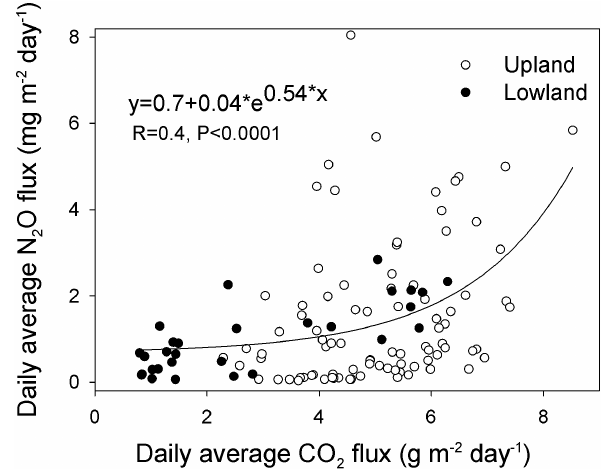
Fig. 2. N 2 O daily average fluxes plotted versus daily average CO 2 fluxes measured in the uphill and downhill sites. Plain line is a linear fit of data ( R 2 = 0 . 57, P< 0 . 0001, DF =